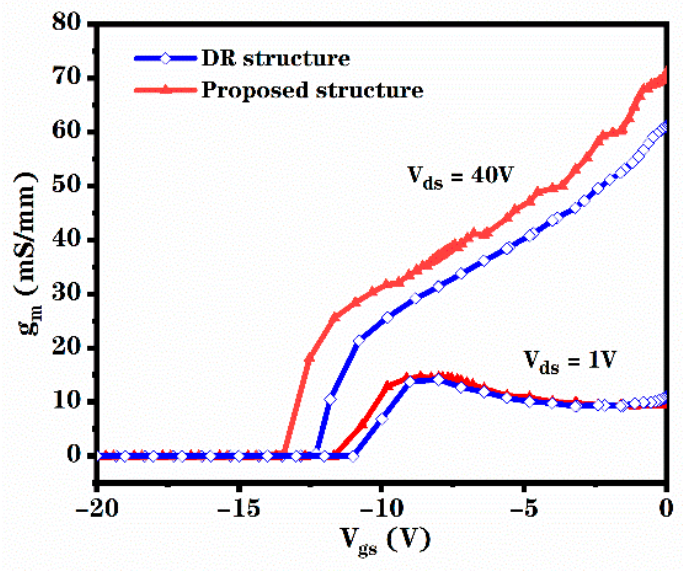
Figure 6. Relationship between gm and V gs for the proposed structure and DR structure at V ds = 40 V and V ds = 1V.